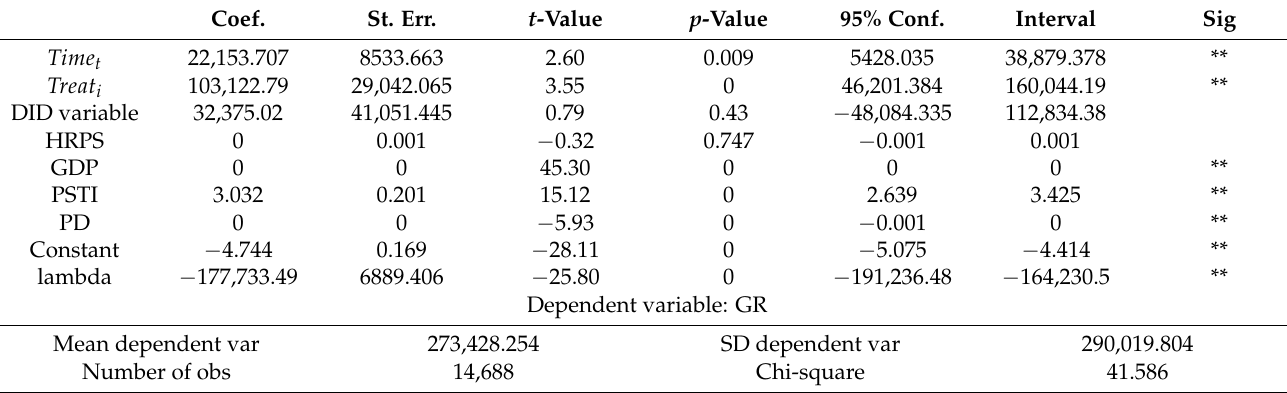
Table 5. Estimation results of Heckman two-step